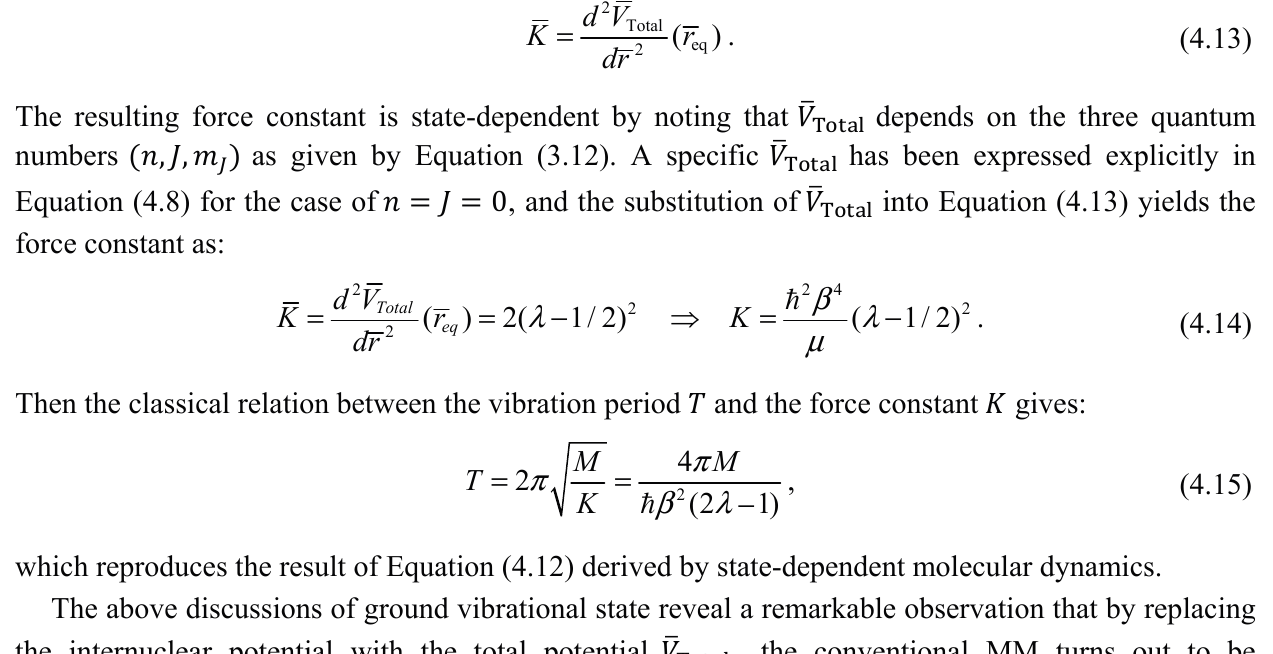
Experiment 12,470 × 10 10 8652 × 10 10 f f